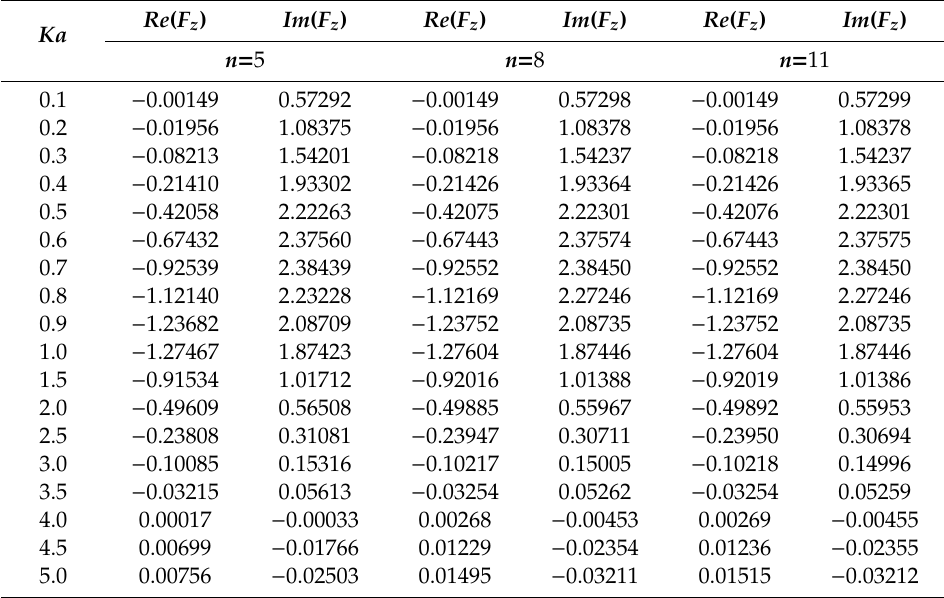
Table 2. Convergence sequence of the computations in terms of the real and imaginary parts of the normalized heave force F z / ρ gAa 2 for di ff erent mode numbers. Slenderness of the oblate spheroid is b / a = 0.8 with an immersion of f / a = 1.0. The normalization is that of Equation